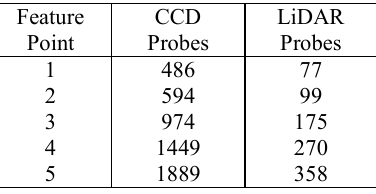
Table 12. 5 Feature Points’ CCD and LiDAR